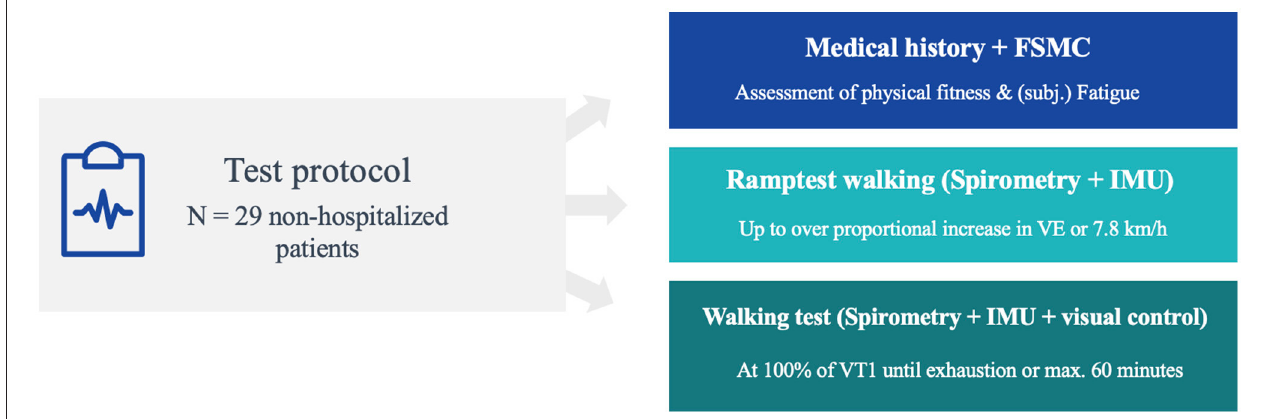
FIGURE 1 | Overview of test protocol consisting of three parts: clinical interview, ramp test and walking test.